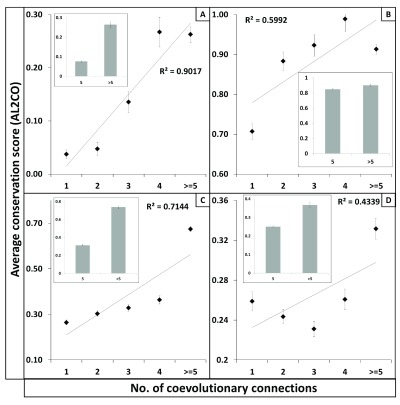
Relationship between coevolutionary connections and evolutionary conservation for protein sites.X-axes show the coevolutionary connection (represented in bins of 1 and 5) per site whereas Y-axes represent the average evolutionary conservation index (CI) estimated by the AL2CO program. Each vertical panel (panel
A–
D) represents results obtained from coevolution predicted by various programs (Panel
A: MIp;
B: McBASC;
C: DCA;
D: PSICOV). Panels provide correlation data for the coevolved sites that are located within or equal to 10Å. The coefficient of determination (R
2) indicates how well the data points fit to the linear regression model between coevolutionary connection and evolutionary conservation. The observed scale of coevolution values obtained from multiple covevolutionary programs varies a lot. The probable reason for such observation can be the algorithm used by individual programs for calculation of covariation/coevolution.